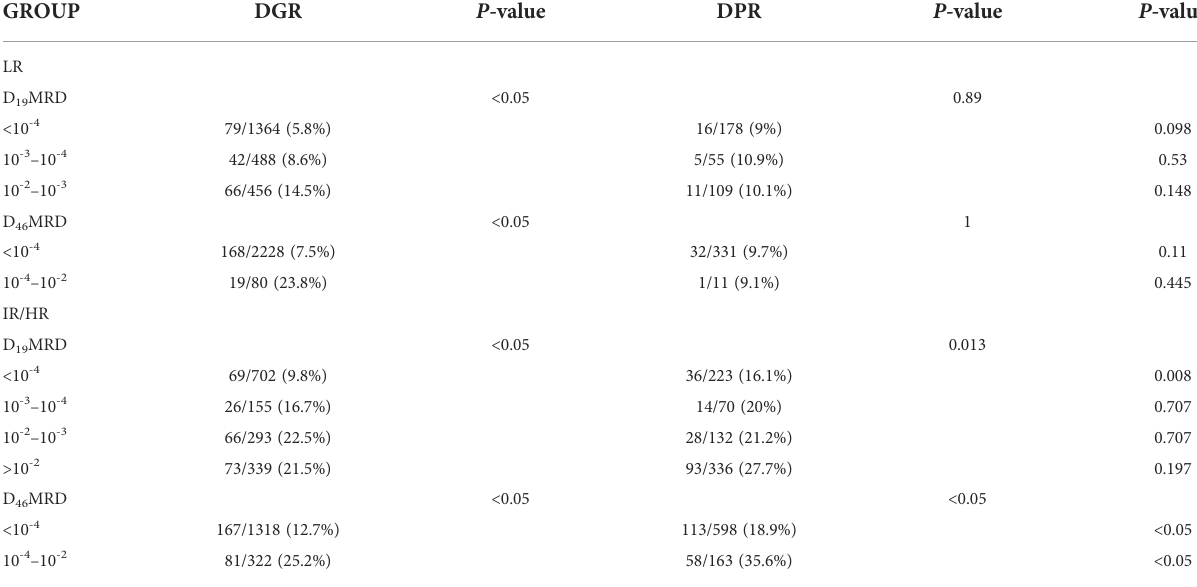
TABLE 4 Relationship between early treatment response and relapse in two groups.